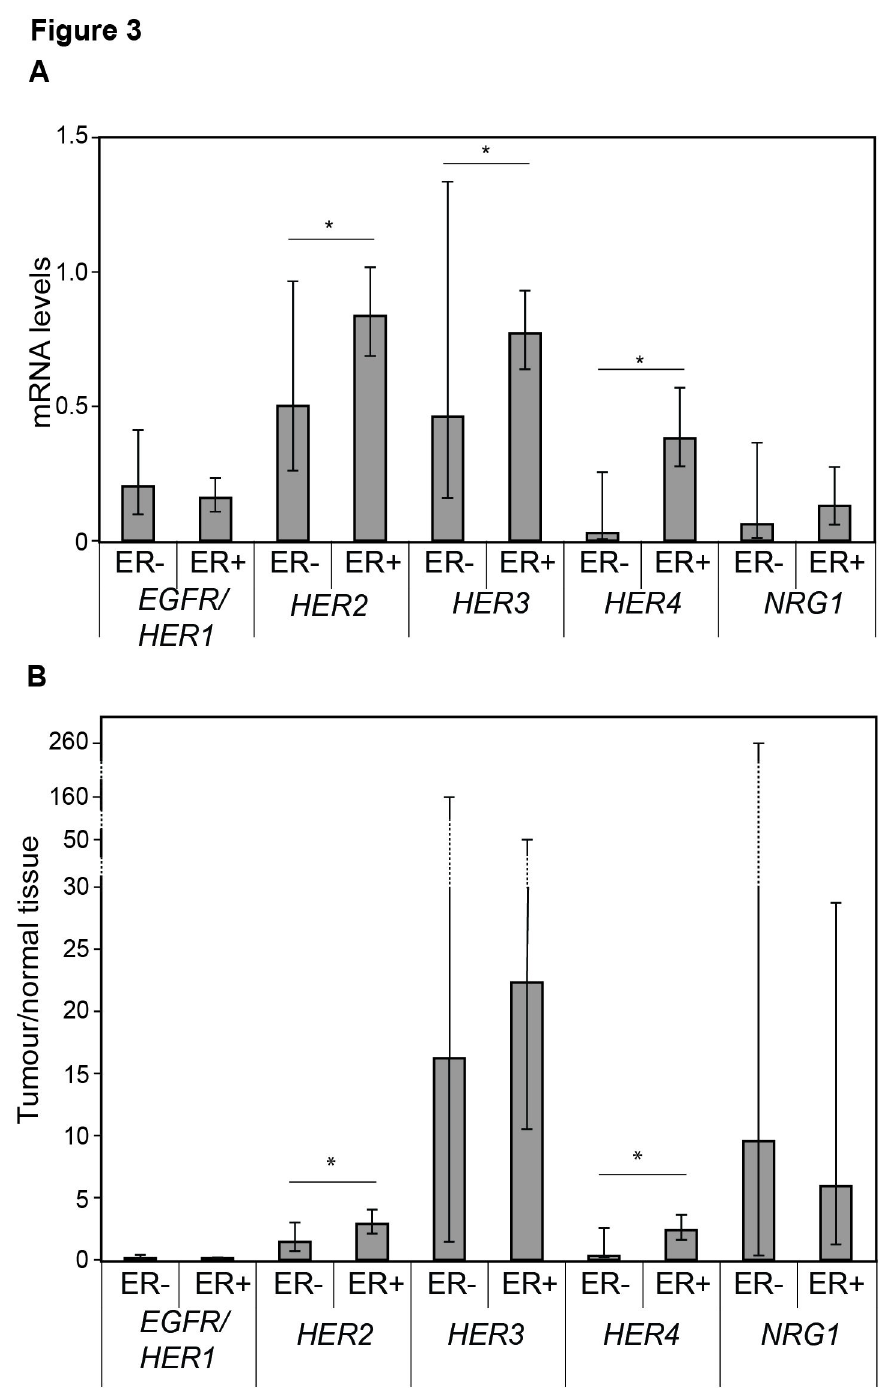
Figure 3. HER1-4 and NRG1 levels related to estrogen receptor status. Geometric mean with 95% confidence intervals of the HER -receptors and NRG1 in estrogen receptor positive (ER+) and ER negative (-) tumours (A) and intervals of tumour to normal tissue ratio (B) among all patients with HER2 non-amplified disease. Significant differences between ER+ and ER- tumours are presented using the Mann-Whitney U test.